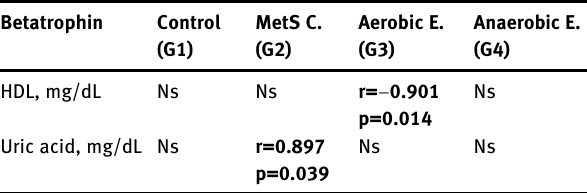
Table  : Signi fi cant correlations with betatrophin in all groups.